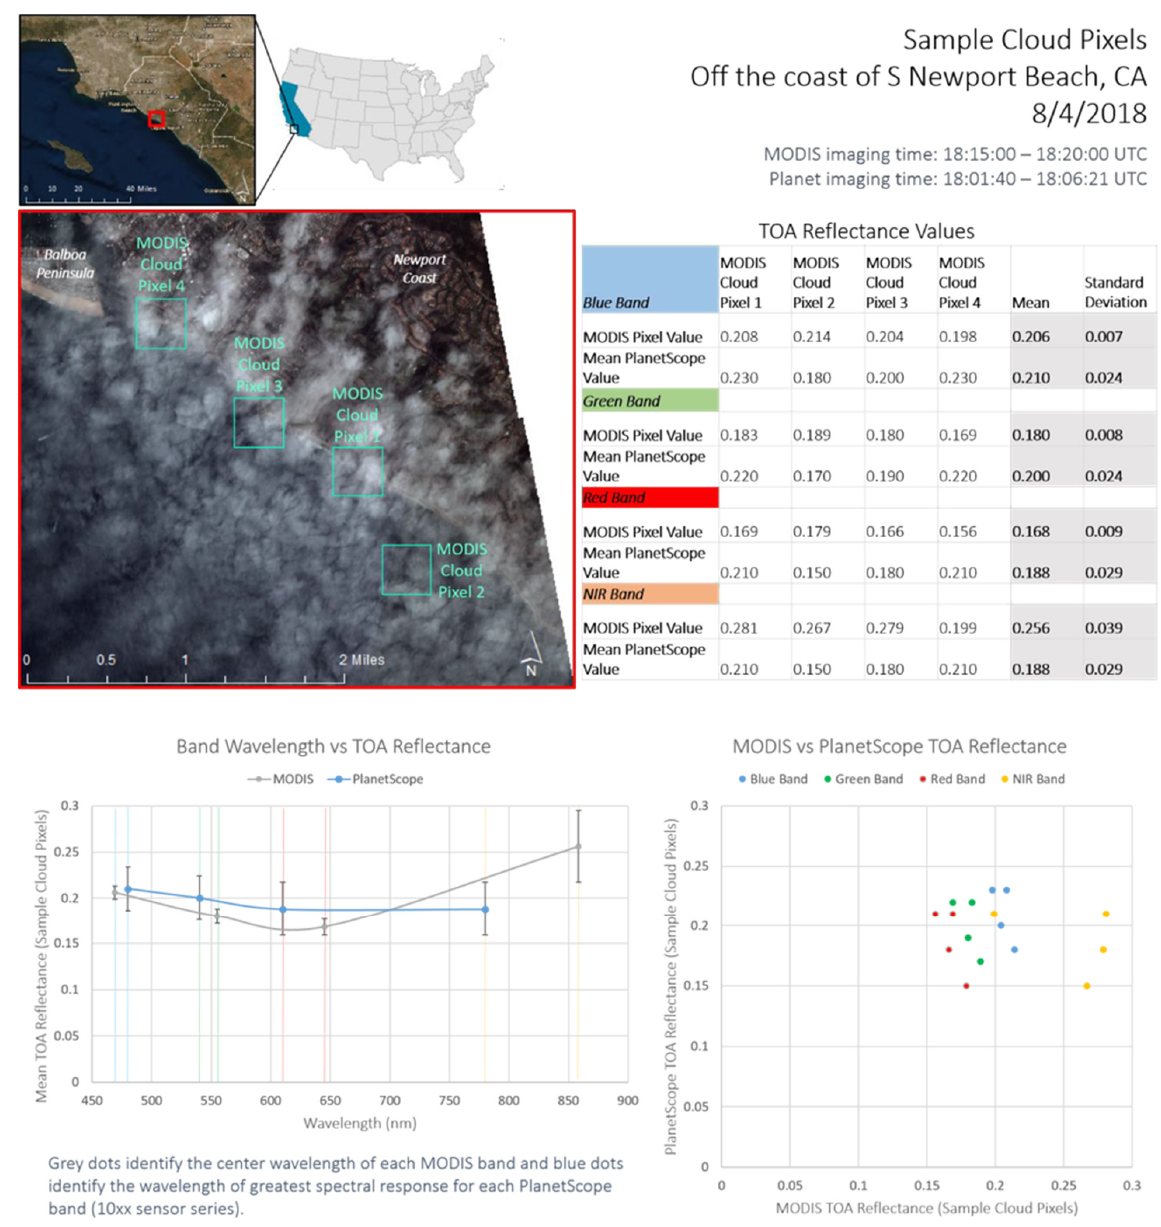
Figure A3. Results from Section 3.2 for pixels sampled over clouds in the Los Angeles study area on 8/4/2018.